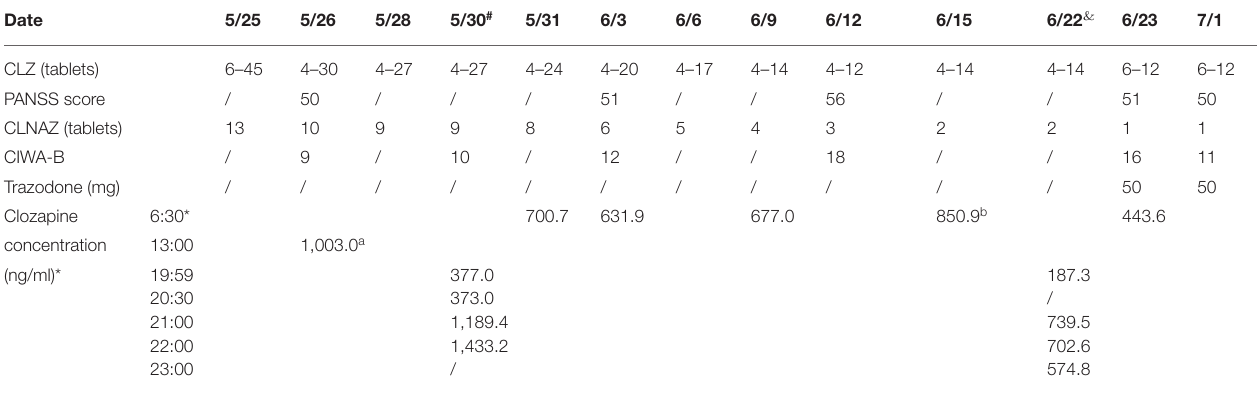
TABLE 1 | Changes in dosage of clozapine (CLZ), clonazepam (CLNAZ) and trazodone, the rating scale score of Clinical Institute Withdrawal Assessment scale-Benzodiazepines (CIWA-B), Positive And Negative Syndrome Scale (PANSS), and the serum concentration of CLZ